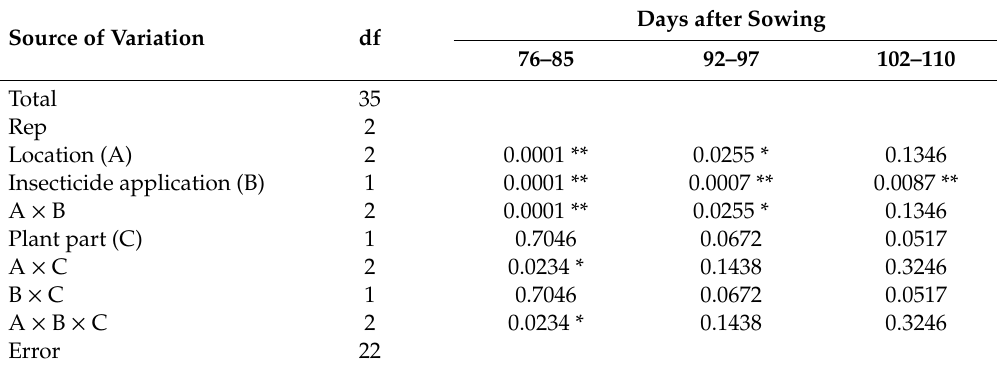
Table 11. Thiamethoxam (including chlothianidin) residues in the di ff erent plant parts during the vegetation period in